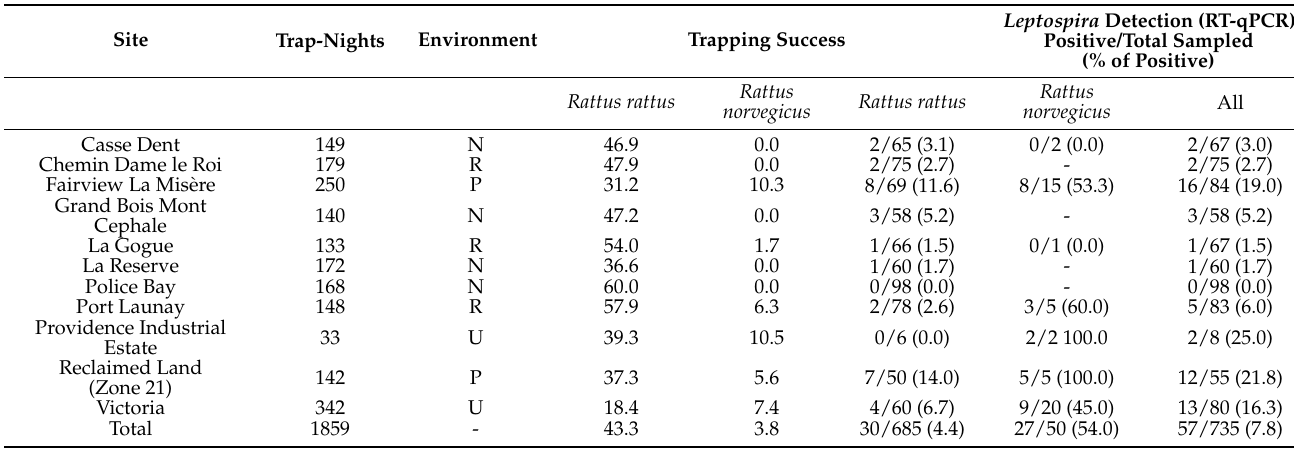
Table 1. Rodents trapping results and Leptospira infection prevalence by sample site. The type of environment is provided for each site: urban (U), peri-urban (P), rural (R) and natural (N). Leptospira Detection (RT-qPCR) Site Trap-Nights Environment Trapping Success Positive/Total Sampled (% of Positive) Rattus rattus Rattus norvegicus Rattus rattus Rattus norvegicus